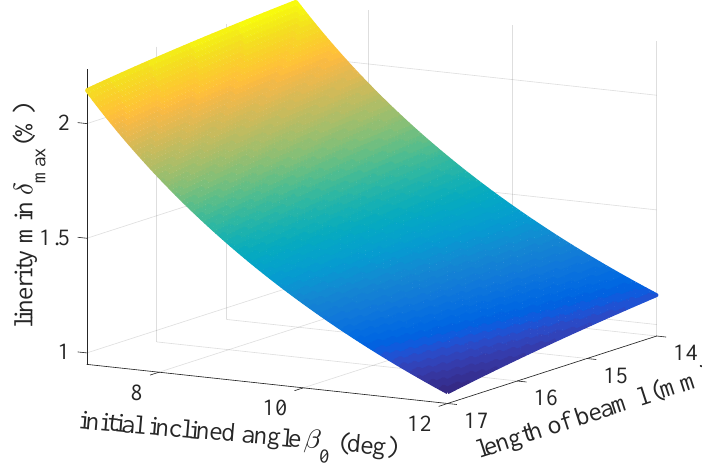
Figure 5. Analysis for optimal solution of evaluation function of linearity with the variation of the length of beam l and initial inclined angle β 0 .